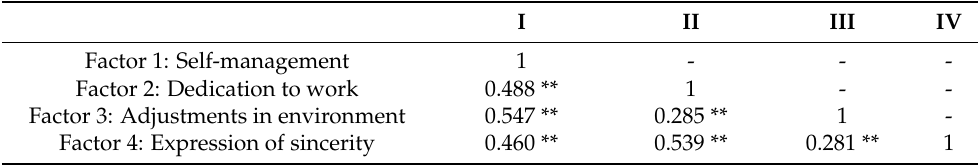
Table 4. Correlations among factors in continued employability.